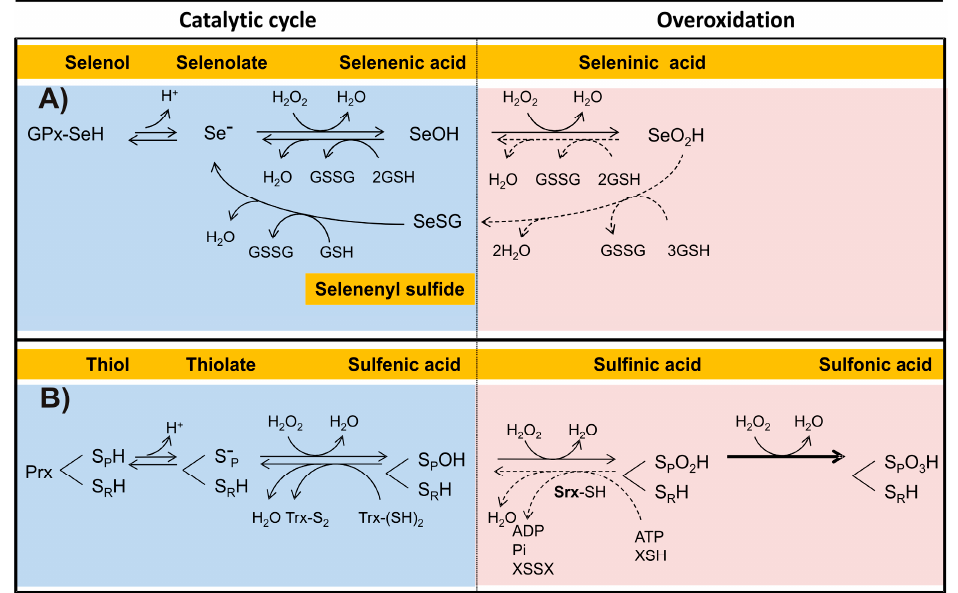
Figure 4. General catalytic cycles involved in H 2 O 2 reduction by either thiol- or selenol-dependent peroxidases in invertebrate parasites. ( A ) Sec-dependent Glutathione Peroxidase; ( B ) Cys-dependent Glutathione Peroxidase; ( C ) dithiol Glutathione Peroxidase-like from Kinetoplastida. Although structurally similar to GPx, the peroxidase from Kinetoplastida is catalytically similar to the tryparedoxin-dependent peroxiredoxin. X-(SH) 2 stand for a dithiol protein from the thioredoxin family ( D ) dithiol peroxiredoxin.